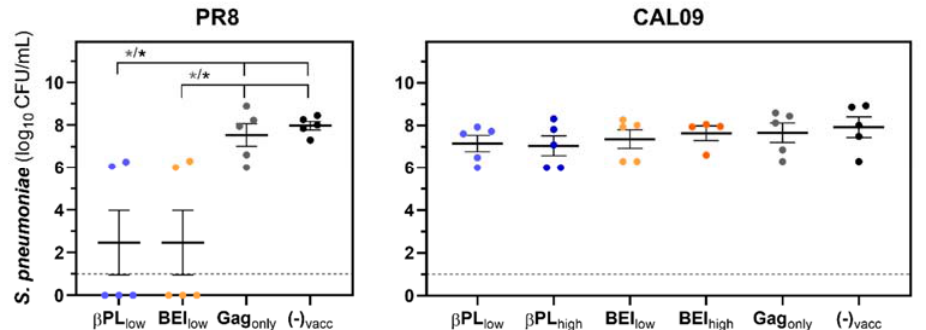
Figure 5. Neutralizing anti-influenza HA immunity renders mice capable of controlling a secondary pneumococcal infection. Immunized or mock-immunized and PR8-infected (left panel) or CAL09-infected mice (right panel) were challenged with 1.25 × 10 6 CFU of a clinical serotype 4 strain of S. pneumoniae five days post influenza and the bacterial burden was assessed in the lungs of mice two days after bacterial infection ( n = 3–5 per group). Color code vaccine groups: β PL low (light blue), β PL high (dark blue), BEI low (light orange), BEI high (dark orange), Gag only (grey), non-vaccinated (black). Symbols represent the titer of an individual mouse and lines and error bars indicate group means +/ − SEM. The dashed line indicates the LLOD of the assay. Statistical significance of mean titers between groups was analyzed by One-Way ANOVA and the Tukey posthoc test or a Kruskal–Wallis test with a Dunn’s correction factor on basis of log-transformed data with * p adj < 0.05.